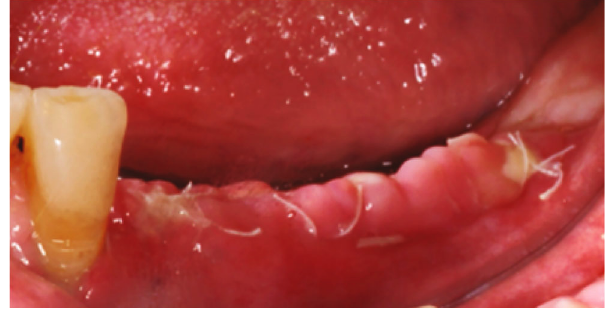
Figure 15: Day 7 after surgery.